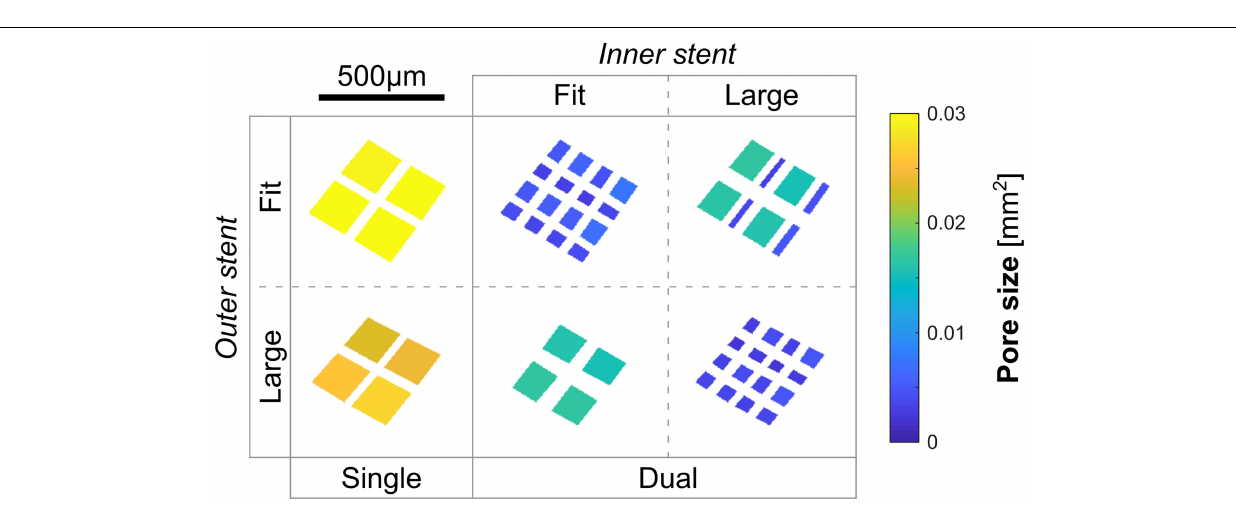
FIGURE 5 | Projections of pores in a representative region of the FD stent in the microstructural analysis of case ID C0016. When strands of the earlier- and the later-deployed stents were partially overlapped (refer to the middle image in the bottom row), the pore size could still be decreased by around 30%, while the number of pores ( n = 4) within the region of interest (pore density) remains